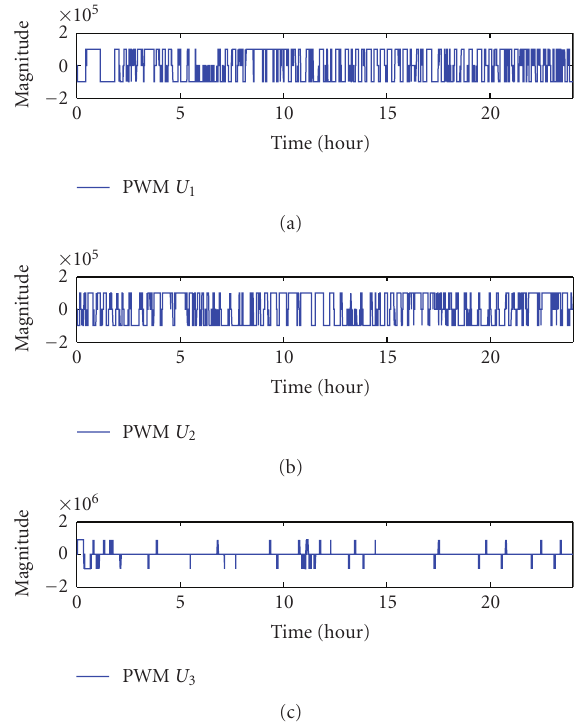
Figure 18: PWM control inputs of Scenario 2 with fault-tolerant